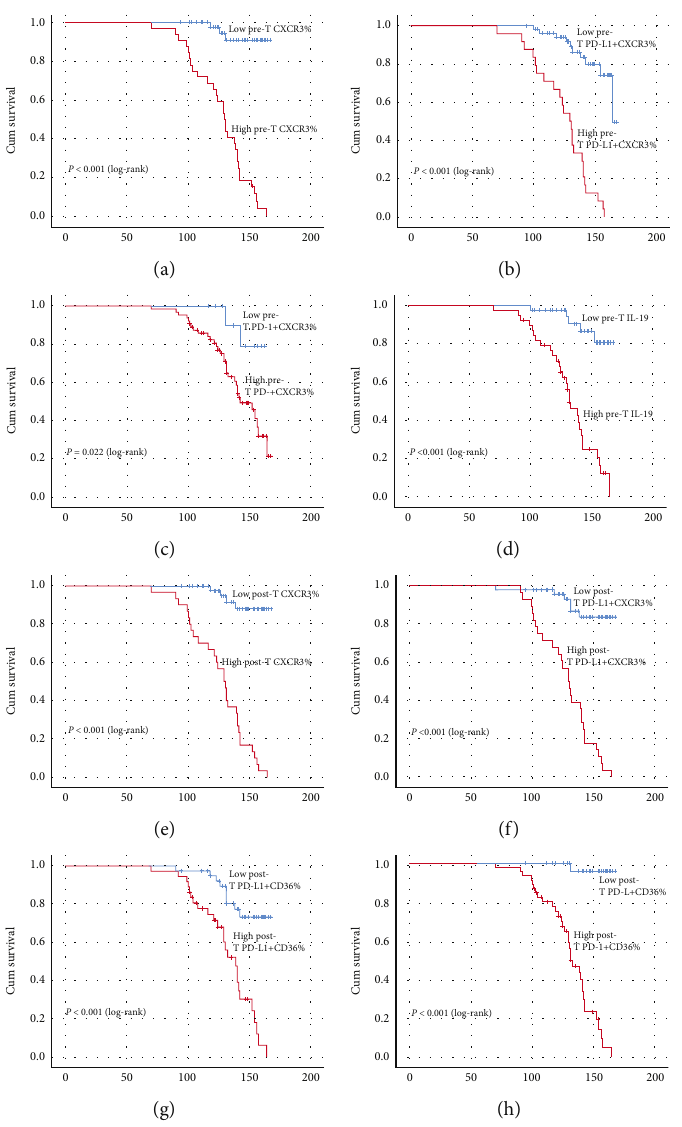
Figure 3: Kaplan-Meier analysis of EFS for IL-19 and PD-L1/PD-1 coexpression with CXCR3/CD36 status. (a) Pretherapy CXCR3+ lymphocytes. (b) Pretherapy PD-L1+CXCR3+ lymphocytes. (c) Pretherapy PD-1+CXCR3+ lymphocytes. (d) Pretherapy IL-19. (e) Posttherapy CXCR3+ lymphocytes. (f) Posttherapy PD-L1+CXCR3+ lymphocytes. (g) Posttherapy PD-1+CXCR3+ lymphocytes. (h) Posttherapy PD-1+CD36+